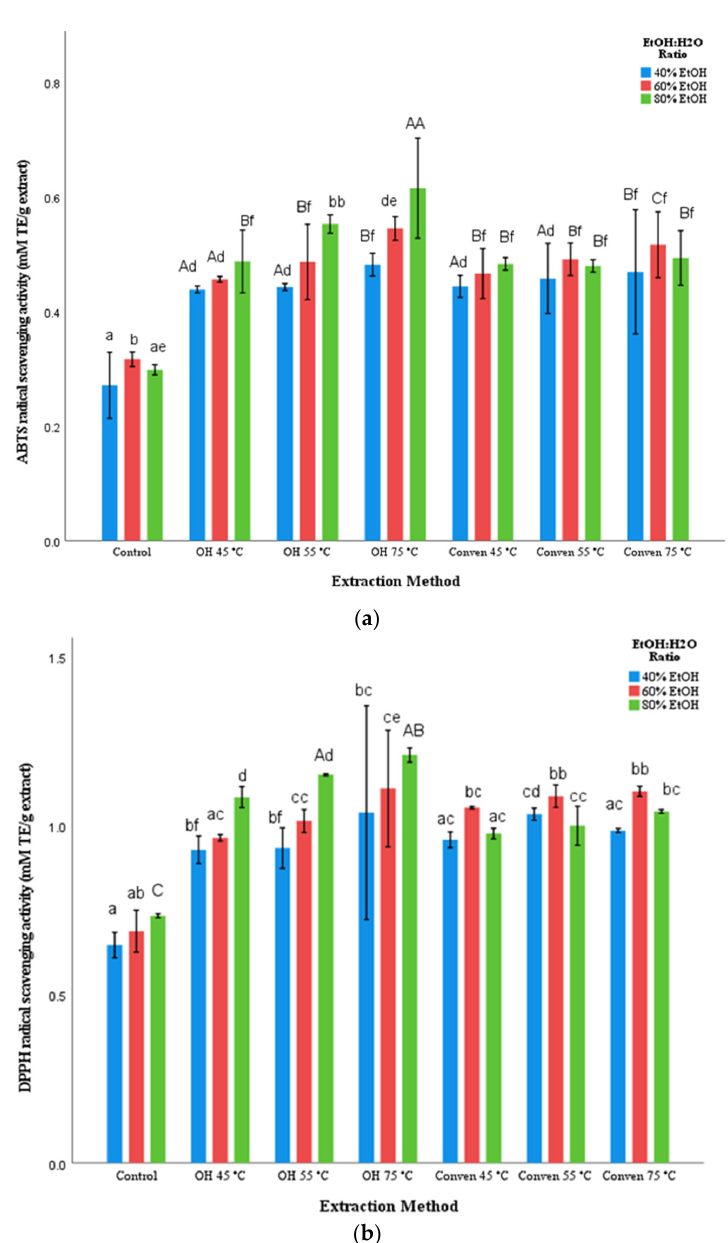
Figure 5. Mean values of Trolox equivalent antioxidant capacity (TEAC) in olive leaf extracts. ( a ) ABTS radical scavenging activity (mM TE/g extract d.w.). ( b ) DPPH radical scavenging activity (mM TE/g extract d.w.). Different letters (a–f, A–C) above the bars indicate statistically significant differences between means ( p < 0.05). The Control represents the extraction with no heat treatment (25 ◦ C). The OH represents ohmic extraction using different ratios of aqueous ethanol (40%, 60%, and 80% EtOH v / v ) and different temperatures (45 ◦ C, 55 ◦ C, and 75 ◦ C), The Conven represents groups of samples with conventional heating using the same solvent ratios/temperatures as those in OH